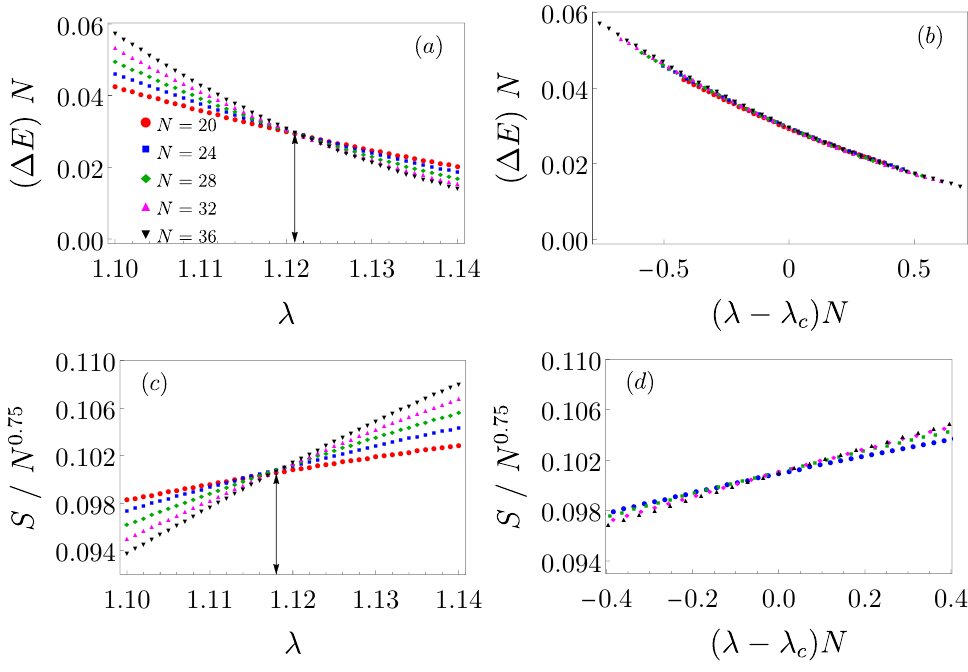
Figure 6: (a): Exact numerics confirming the presence of the Ising transition for = 2.0 and w = 0.1 (a): Plot of ( ∆ E ) N z for a two-leg ladder as a function of λ for V 0 ≃ 1.121 for z = 1. (b) Plot of ( ∆ E ) N z as a several N showing a crossing at λ = λ c ) showing perfect scaling collapse for z = ν = 1. (c): Plot function of N 1 /ν ( λ − λ c ≃ 1.118 for η = 0.25. (d) of SN 2 − z − η as a function of λ showing a crossing at λ c ) N 1 /ν showing scaling collapse for ν = 1, Plot of SN 2 − z − η as a function of ( λ − λ c λ ≃ 1.118, and η = 0.25. All energies are scaled in units of ∆ . See text for c